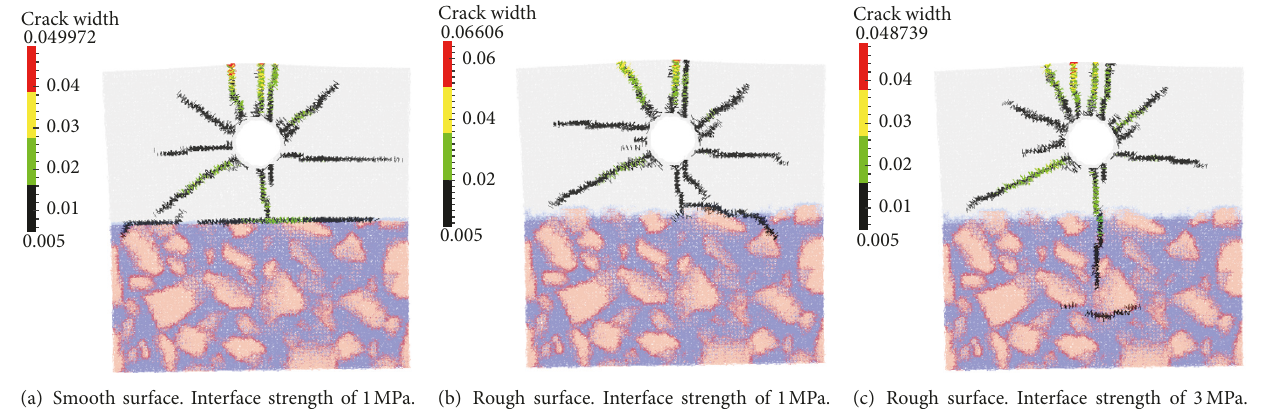
Figure 14: Numerically obtained crack pattern and maximum crack widths due to the pressure imposed by expanding bar in repair systems. SHCC is used as a repair material, influence of the substrate surface roughness, and the interface strength (deformation scaled 20x; note that for different samples maximum crack widths are different).